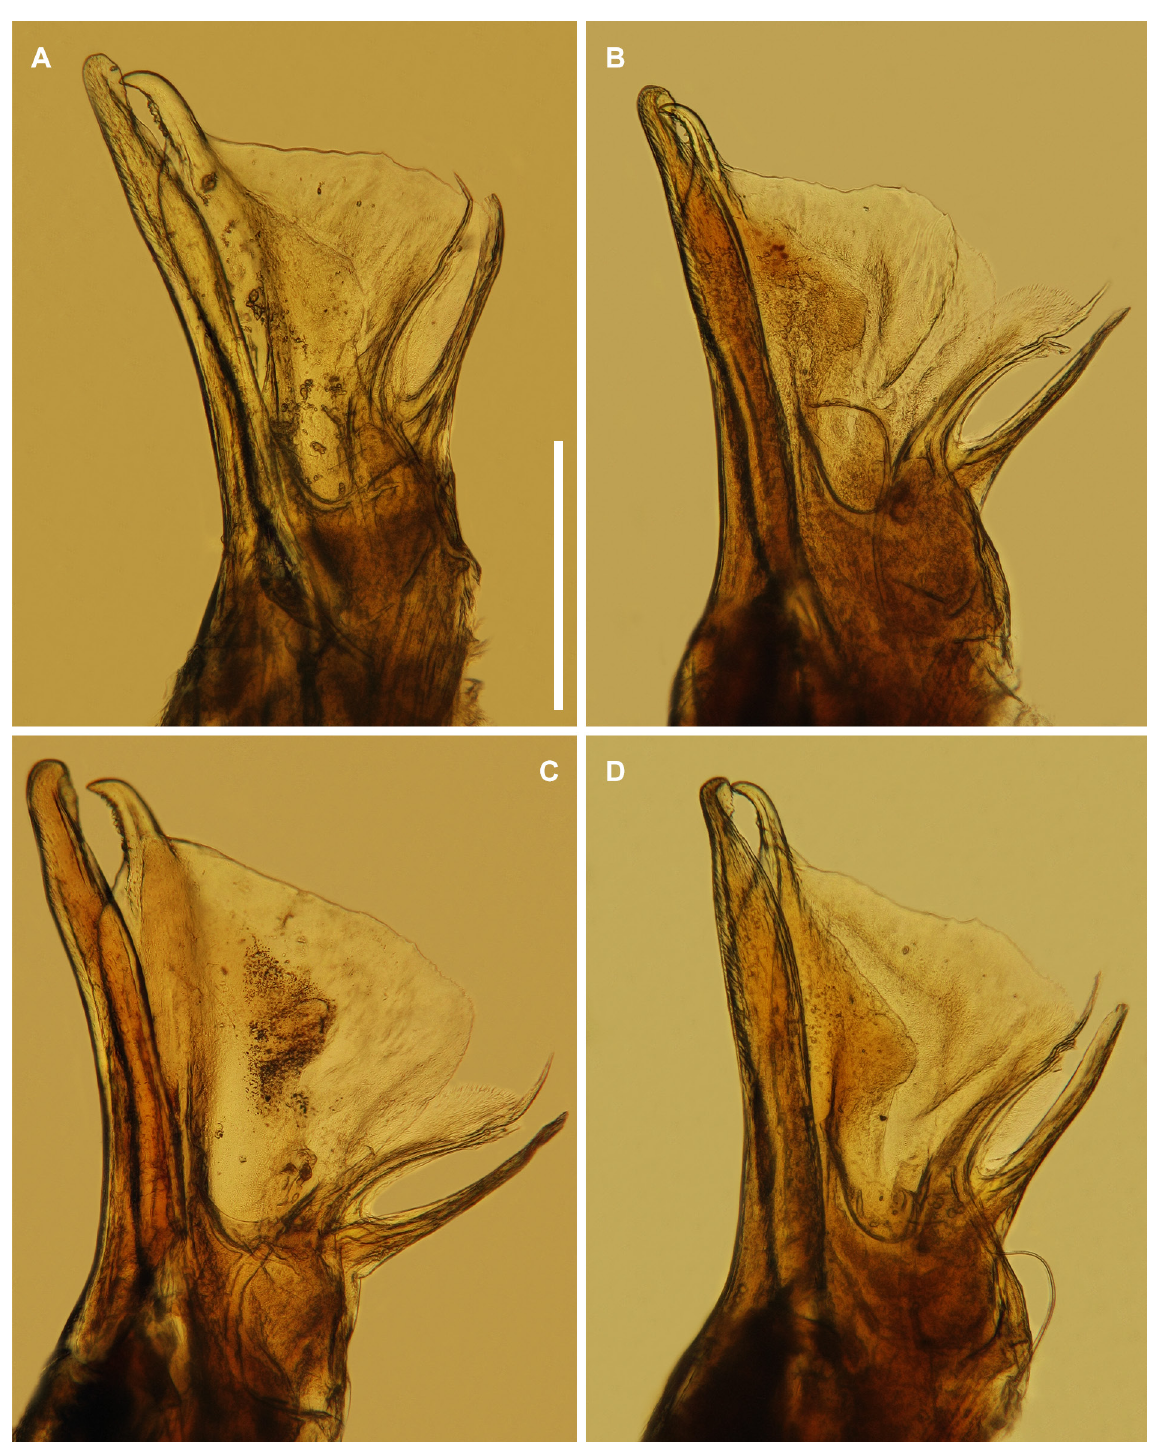
Fig. 5. Leucogeorgia abchasica (Lohmander, 1936) comb. nov., left gonopods, mesal views (ZMUM). A . ♂ from Tsebeldinskaya Cave. B . ♂ from Abraskila Cave. C . ♂ from Bolshaya Medveditza Cave. D . ♂ from Snezhnaya Cave. Scale bar: 0.3